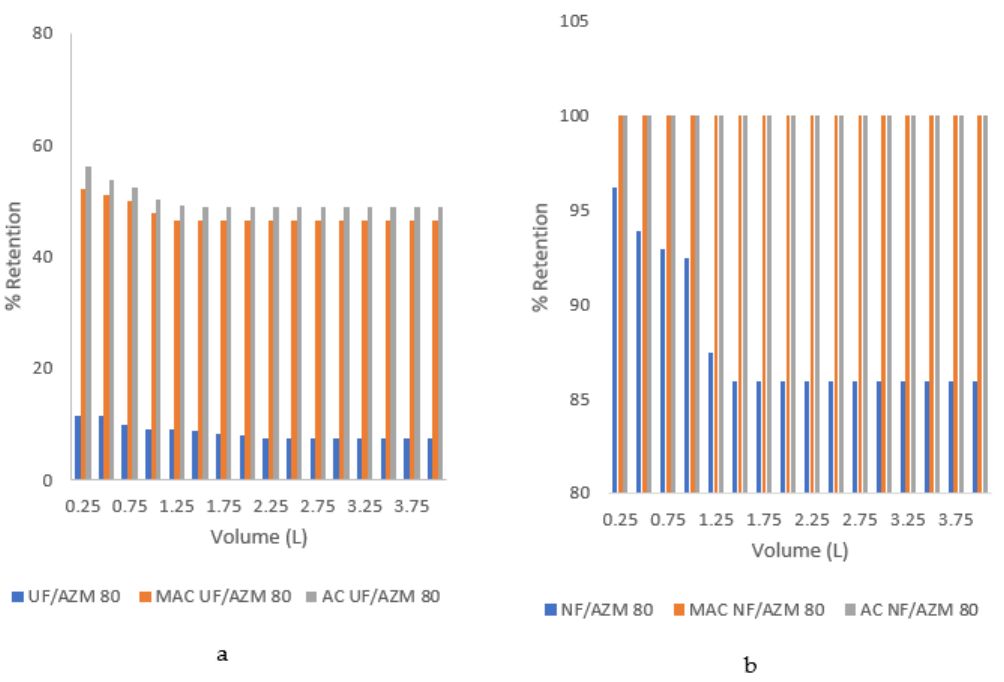
Figure 12. Percent retention of AZM by membranes ( a ) UF membrane ( b ) NF membrane.